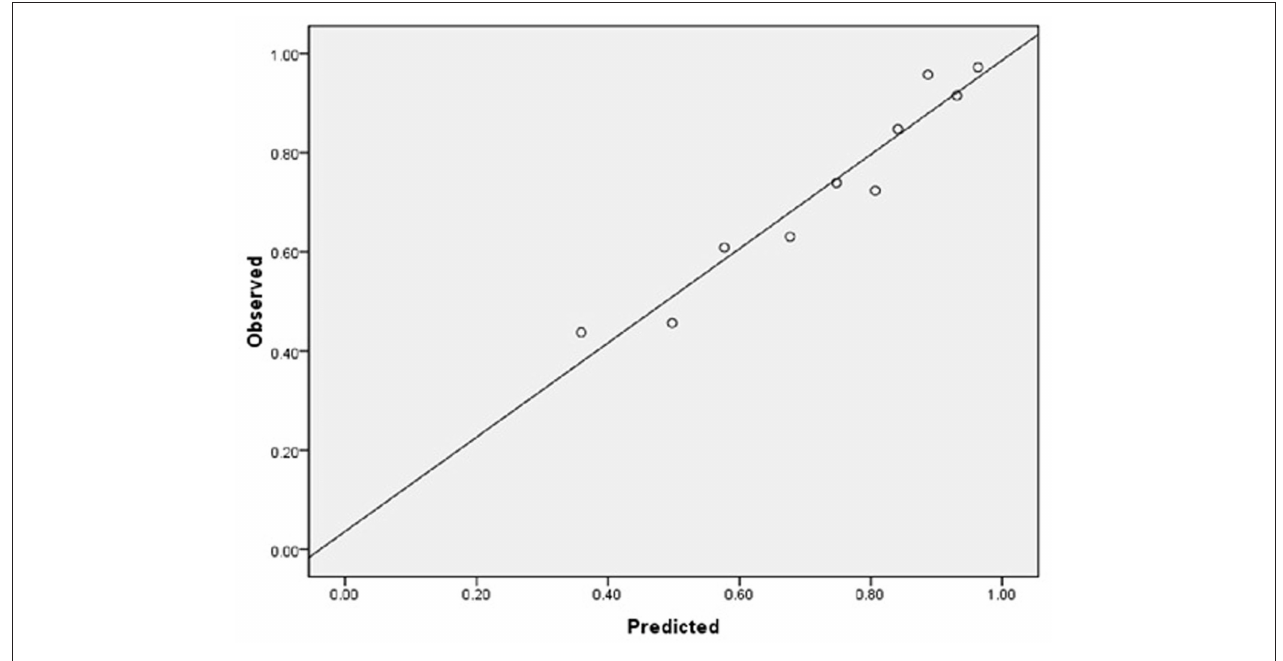
FIGURE 1 | The calibration plots (predicted vs. observed results).